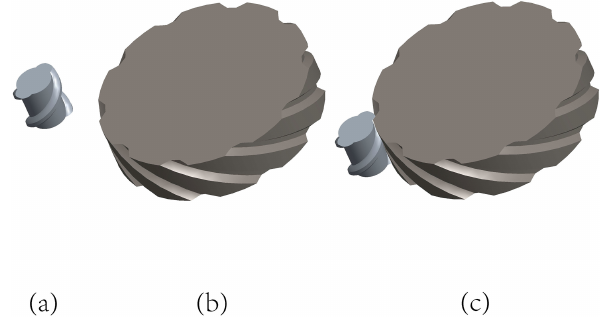
Figure 10. 3-D solid model 3. (a) Driving gear 3; (b) driven gear 3; (c) meshing simulation.